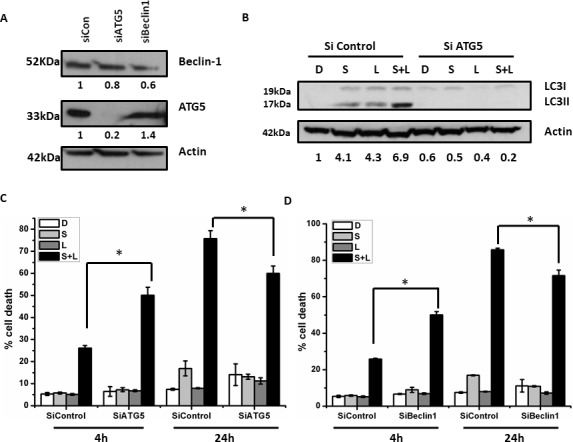
Knockdown of autophagy genes increases cell death during early treatment times with siramesine and lapatinib but inhibits cell death at a later times.(A) Knockdown of autophagy genes Atg5 and Becn1 by siRNAs as demonstrated by western blot of Atg5 and Beclin-1, respectively, in MDA MB 231 cells. The protein level of Atg5 was represented by the Atg5-Atg12 complex since the conjugation between these two proteins is an essential step during a functional autophagy process (and same hereafter). (B) Inhibition of autophagy by knockdown of Atg5 as demonstrated by western blot of LC3I/LC3-II in MDA MB 231 cells. (C, D) Effects of knockdown of Atg5 or Becn1 on siramesine and lapatinib-induced cell death at 4 and 24 hours in MDA MB 231 cells. These results were representative of three independent experiments (n = 3), *p<0.05.